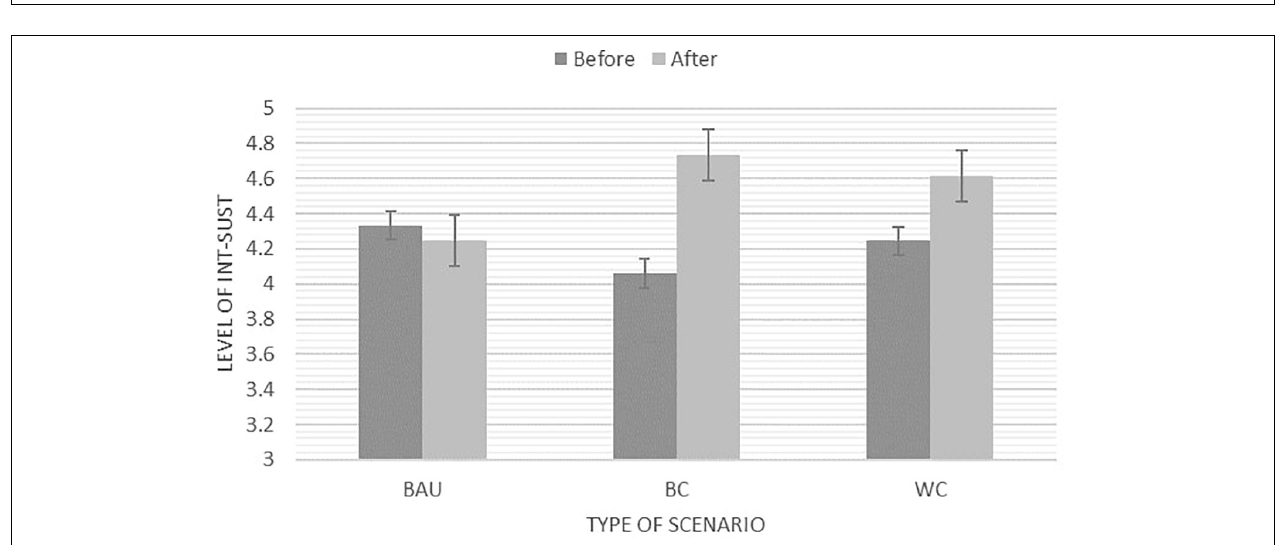
FIGURE 7 | Significant interaction between scenarios after adding CFC as covariate. NB: Y -axis adapted for illustration purposes. The Likert scale ranges from 1 ( Strongly disagree ) – 5 ( Strongly agree ).